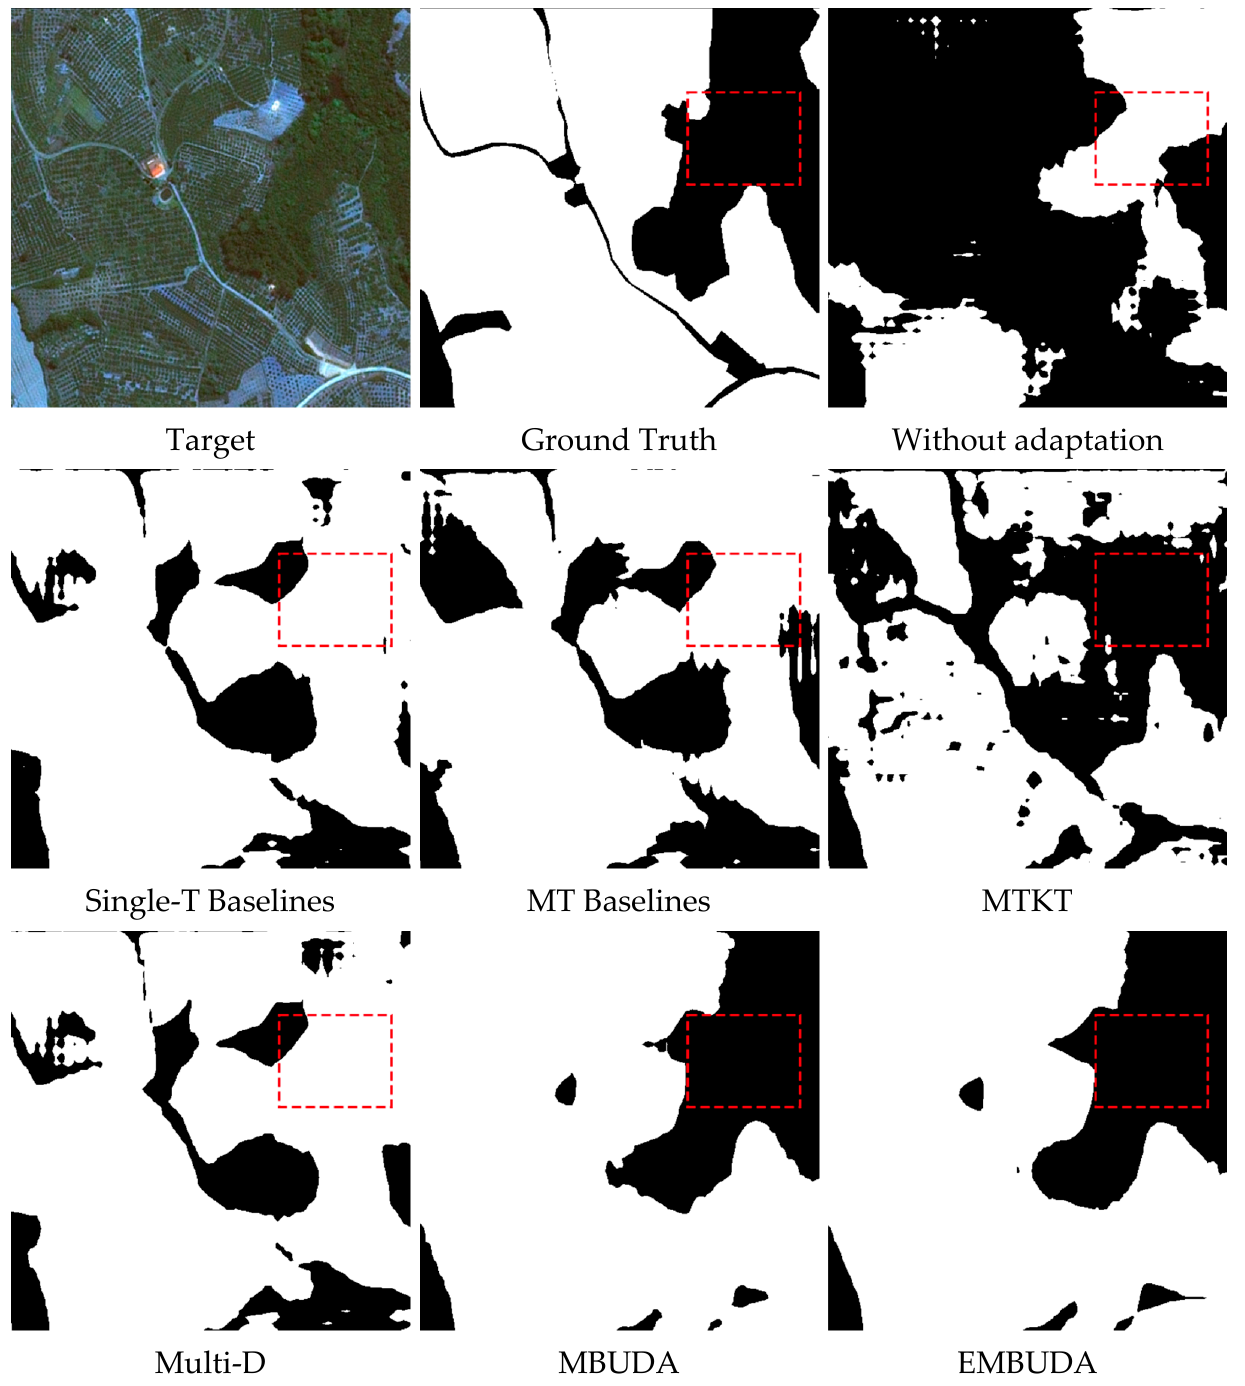
Figure A6. Outputs of orchard area segmentation in Dataset XT2 when adapting from Dataset CY to Dataset XT1 and Dataset XT2.